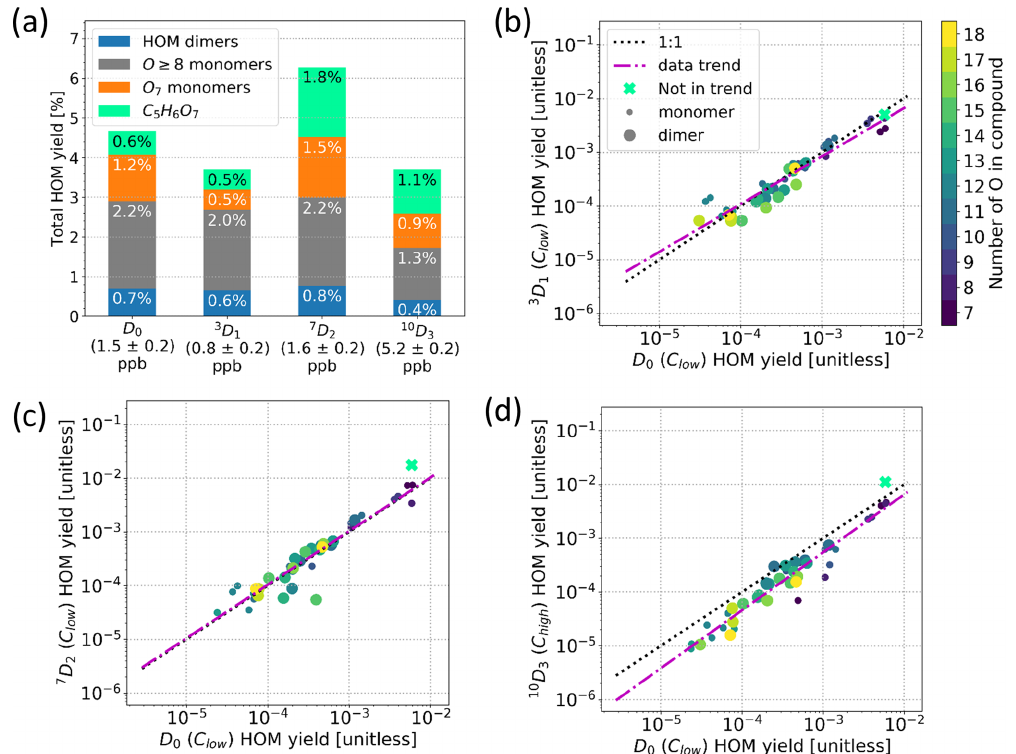
Figure 8. (a) HOM yields for α -pinene samples, where yields for C 5 H 6 O 7 (mint green), O 7 monomers (orange), O 8 + monomers (grey), and dimers (blue) are plotted separately. The corresponding precursor names and concentrations are shown on the x axis. (b–d) Comparison of HOM yields compound per compound between the D 0 sample and 3 D 1 sample (b) , 7 D 2 sample (c) , and 10 D 3 sample (d) , where the mint green cross corresponds to C 5 H 6 O 7 and is excluded from the data trend and the colour shows the number of oxygen atoms in the compound. C low and C high refer to the α -pinene concentration of the sample. Note that each point in panels (b) – (d) corresponds to the yield of the sum of all found isotopes per main